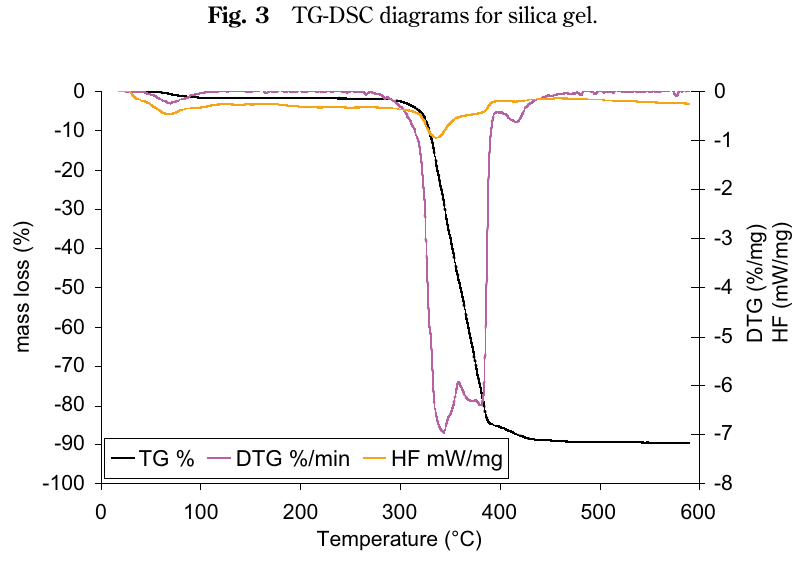
Fig. 4 TG-DSC diagrams for MgSt